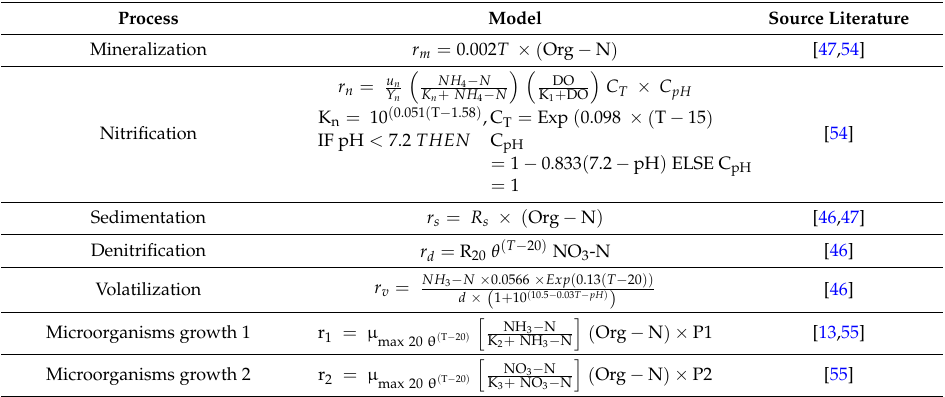
Table 1. Mass balance reaction rate